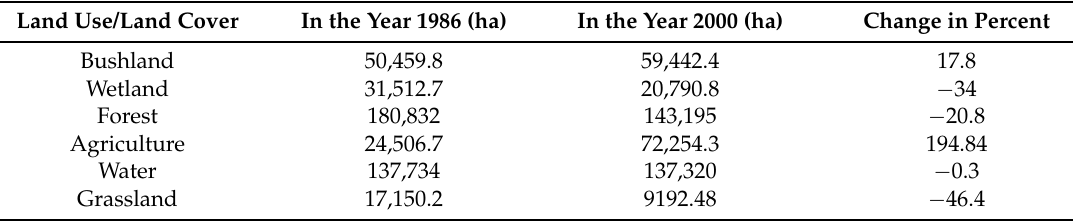
Table 6. Land use/cover changes in Lake Abaya